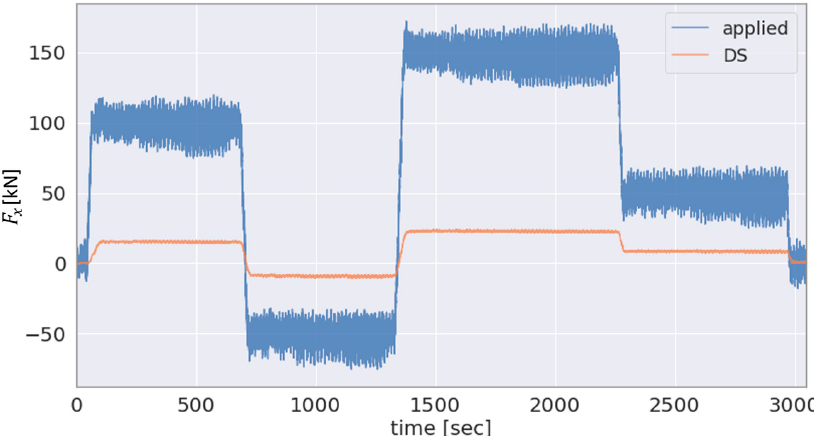
Figure 11. Applied and DS-based estimation in the single-load test scenario for the force 𝐹 (cid:3051) .